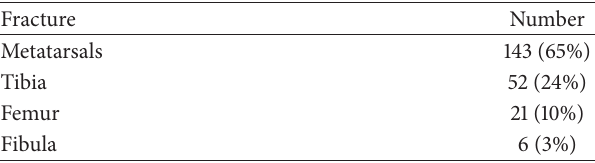
Table 1: Stress fracture type.